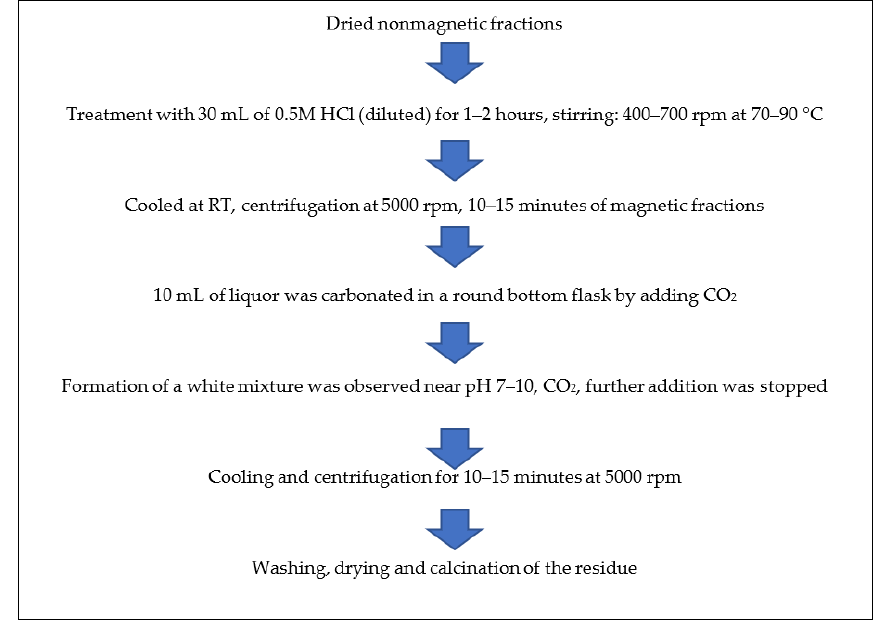
Figure 3. Schematic method for synthesis of alumina particles from non-magnetic fractions of ISA.